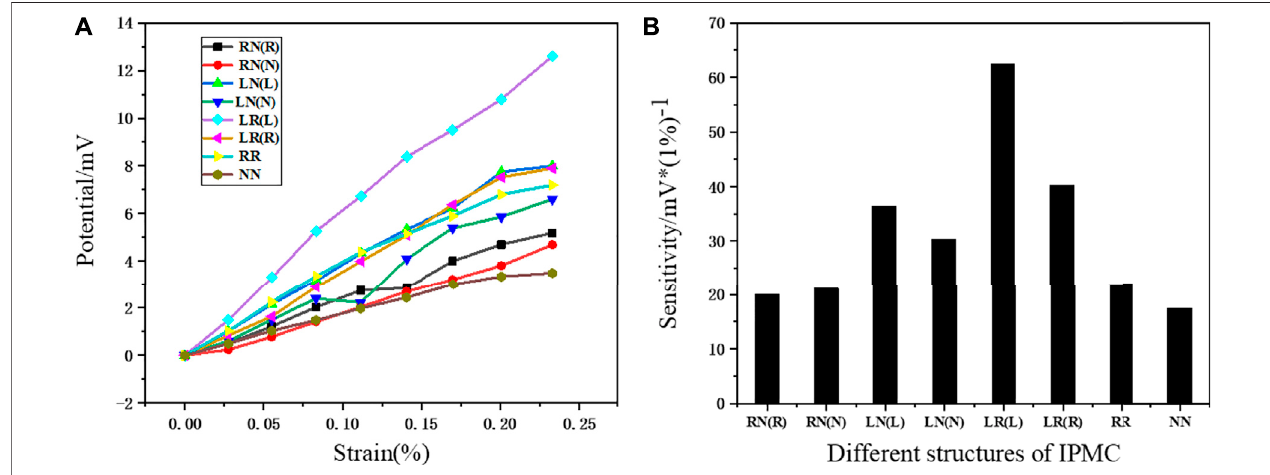
FIGURE 6 | The linearity and sensitivity of the IPMC samples. (A) The strain-voltage curve. (B) The gauge factor value comparison diagram.